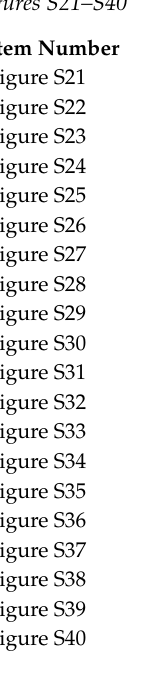
Figure S19 Daytime Figure S20 trig_predicted_night.png Nighttime Scatter plots showing the actual values of each measure (y-axis) and each RMSSD value of daytime or nighttime (x-axis). Grey x indicates measurements from females, black dots indicate measurements from male. A fractional polynomial function represents the average predicted value stratified by sex (dashed black line = males; solid grey line = women) and includes the 95% confidence interval (grey band). The red vertical line aids orientation for the 30 msec RMSSD value.